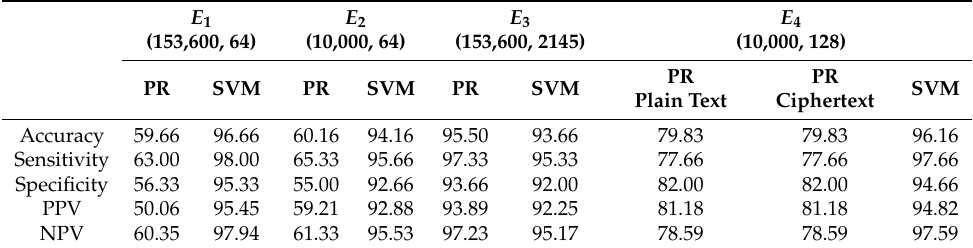
Table 5. Performance comparison when using different input data configurations in the EEG-based predisposition to alcoholism detection use case after applying the voting scheme.